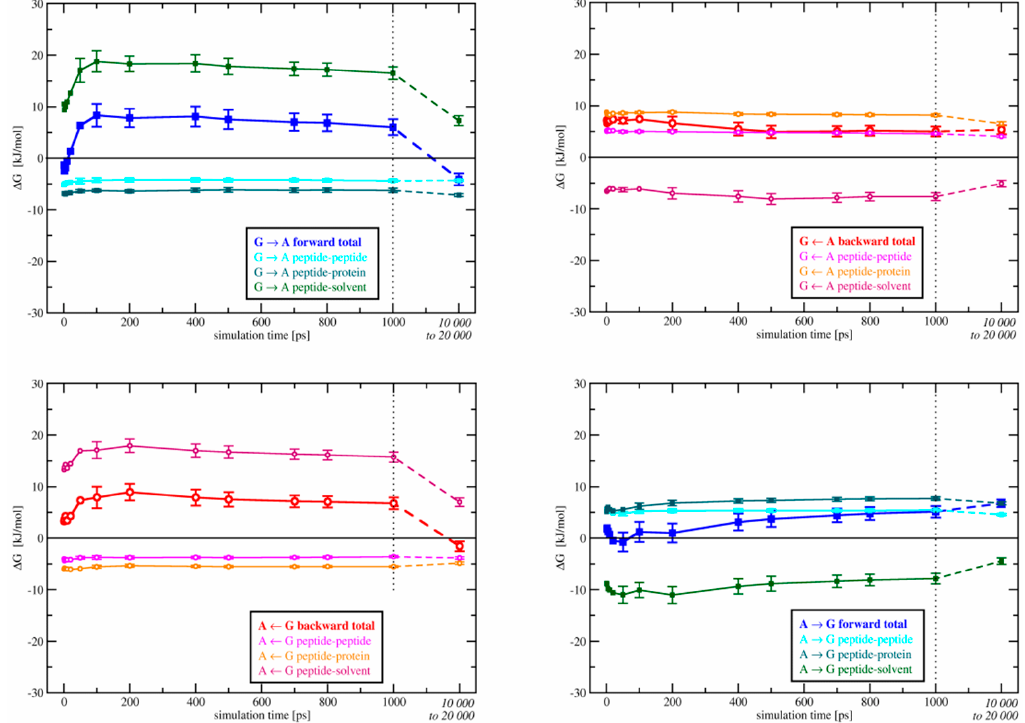
Figure 7. Convergence of individual contributions to the free energy for the transformations between KGK and KAK in OppA. Upper left panel: KGK → KAK forward; upper right panel: KGK → KAK backward; lower right panel: KAK → KGK forward; lower left panel: KAK → KGK backward. Contributions to the free energy are separated for peptide-peptide (intra-peptide), peptide-protein, and peptide-solvent interactions as a function of simulation time per λ -point.